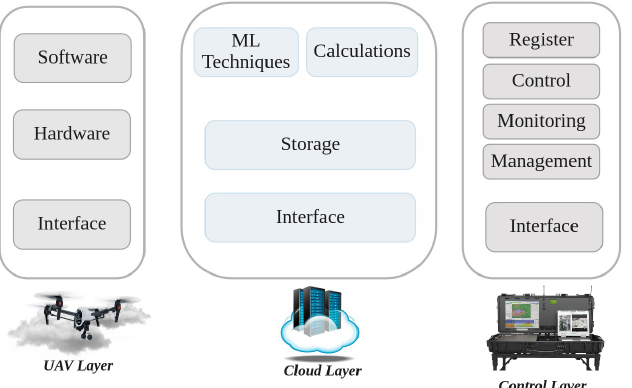
Figure 8. Cloud-based UAV managing system including the three main layers: UAV, cloud, and